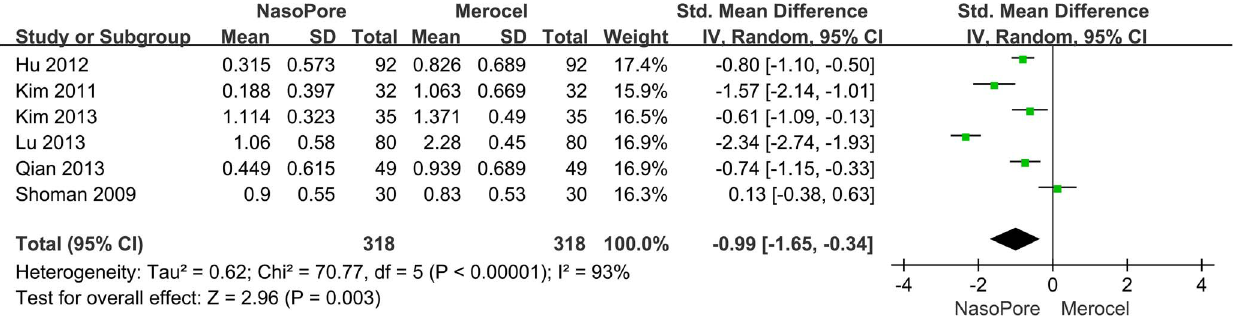
Figure 4. Forest plots of SMD and 95% CI for bleeding upon removal.